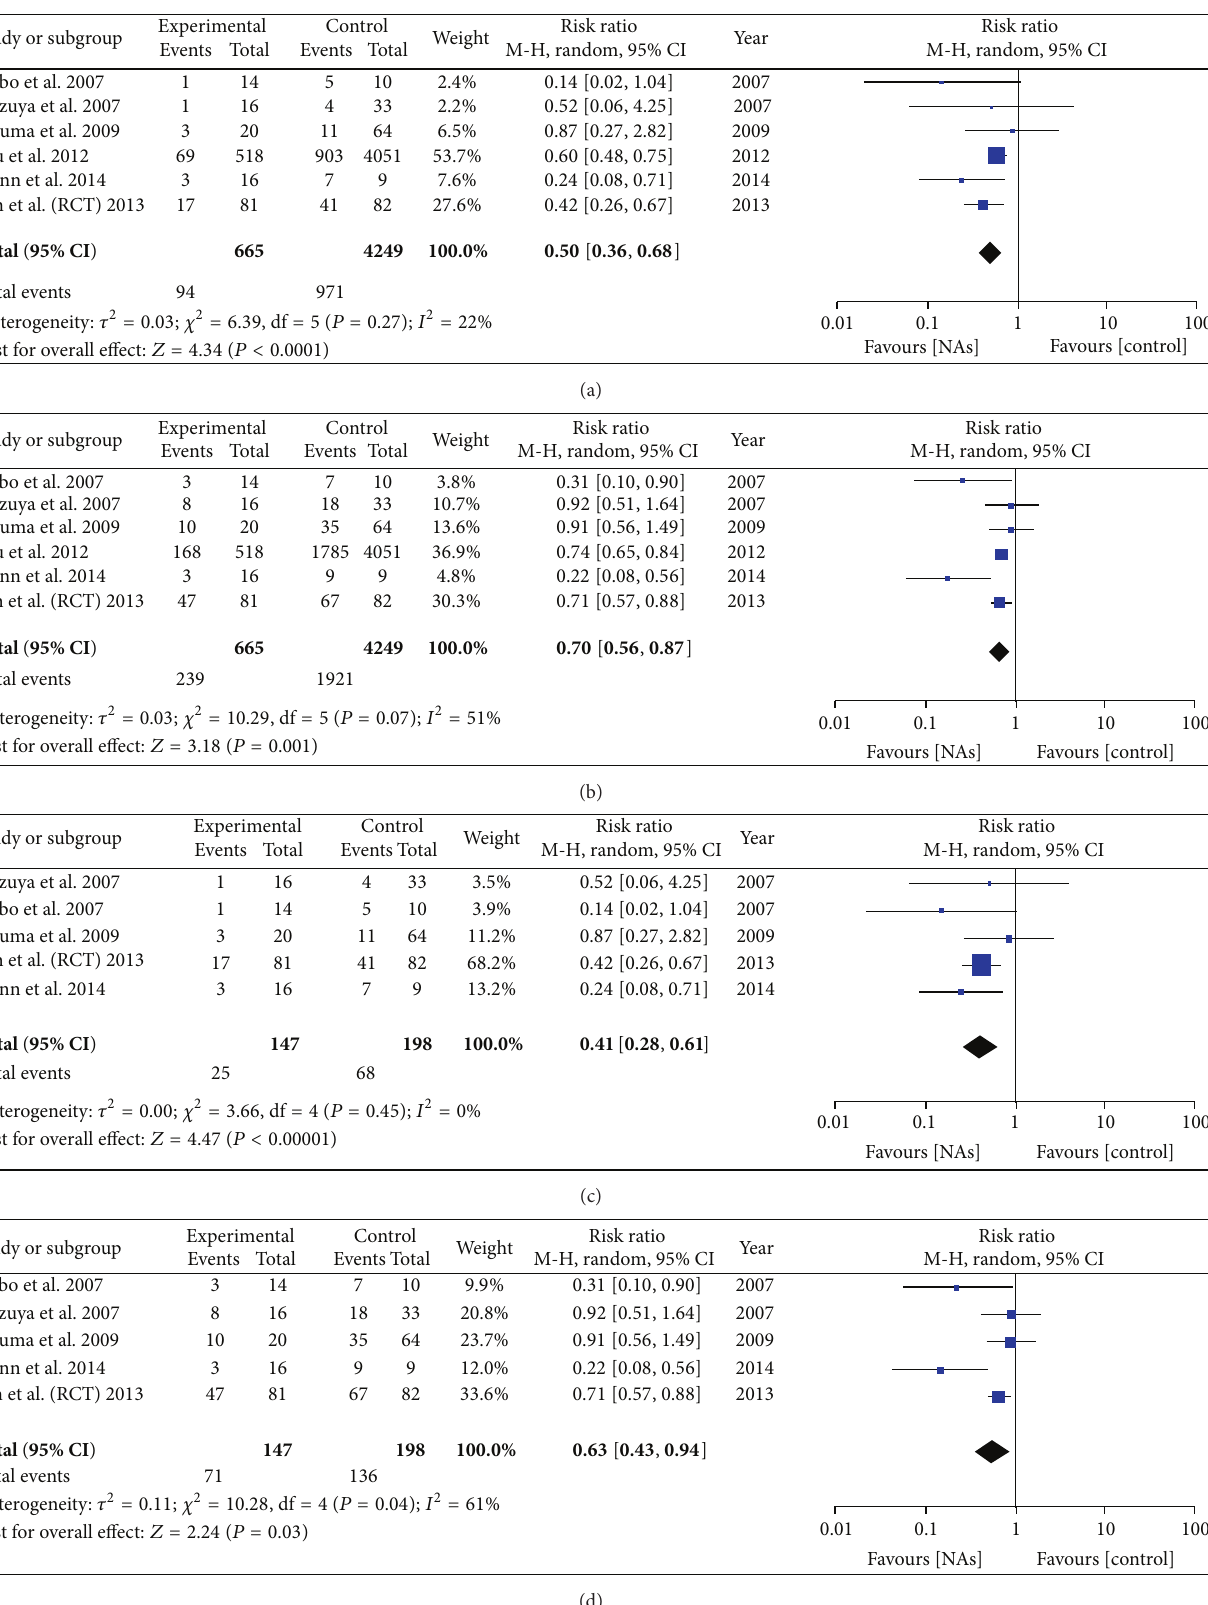
Heterogeneity: 𝜏 2 = 0.11 ; 𝜒 2 = 10.28 , df = 4 ( P = 0.04) ; I 2 = 61% Test for overall effect: Z = 2.24 ( P = 0.03)